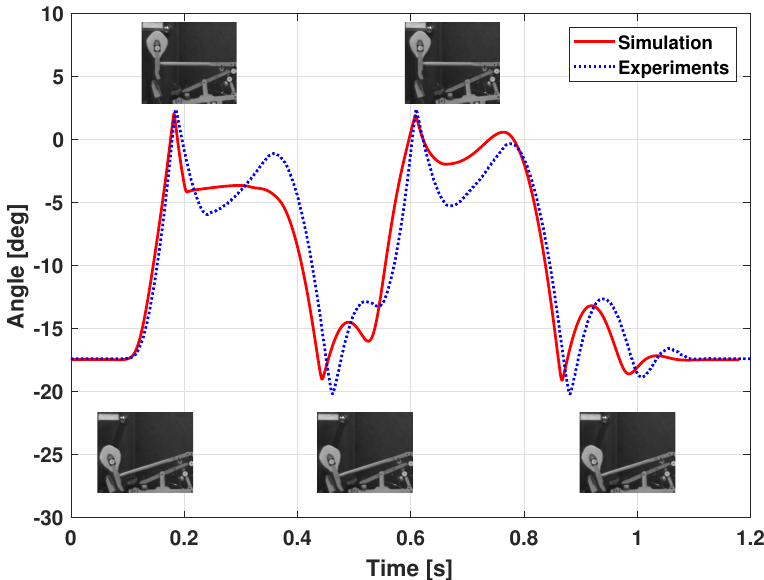
Figure 16. Piano action model dynamic validation: hammer joint position (fast double